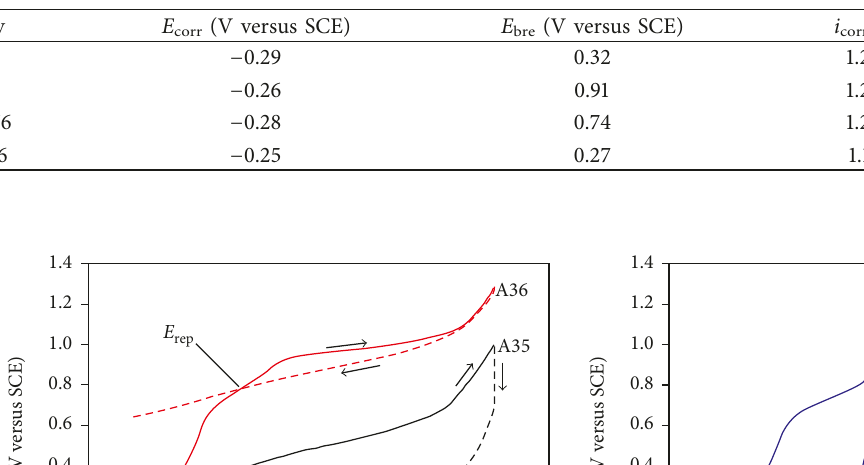
Figure 6: Potentiodynamic polarization curves of HEAs A35 and A36 and commercial alloys C-276 and SS316 in 3.5wt.% NaCl solution saturated at 25 °